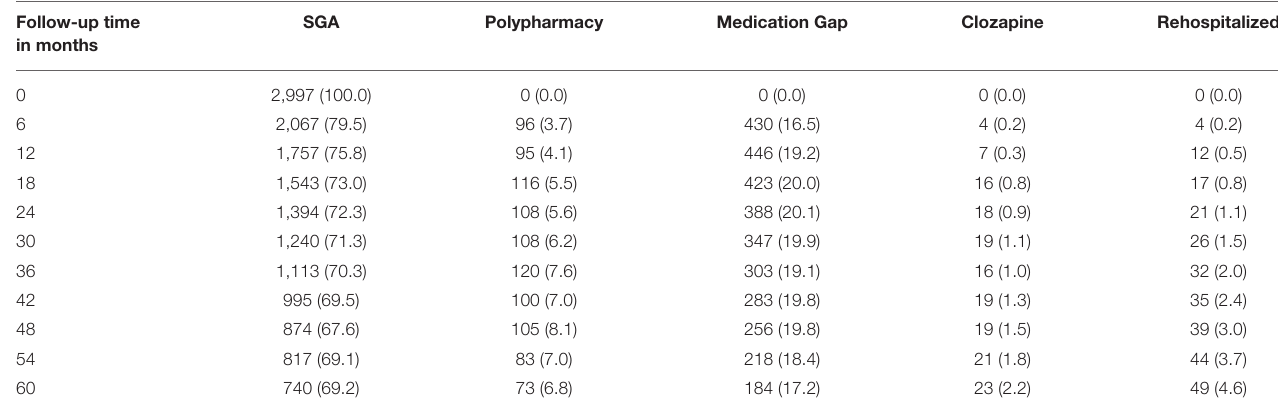
TABLE 2 | Number (%) of patients in a stage by follow-up time (months). The denominator is the total number of patients remaining in the cohort at a given month. Follow-up time in